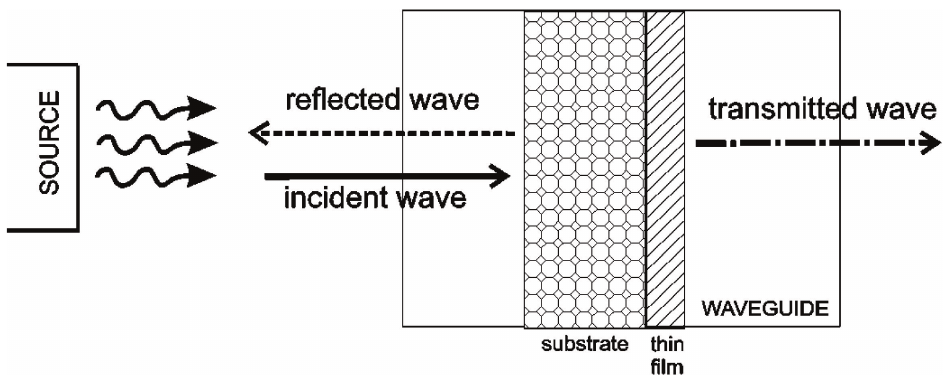
Figure 2. The waveguide measurements setup in the “quartz + PyC”